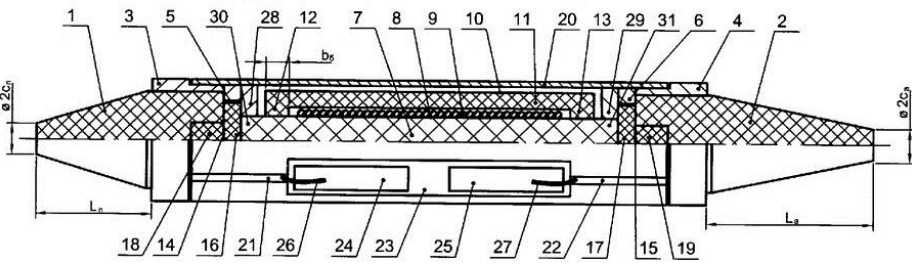
Fig. 2. Draft of the integrated PAA element.